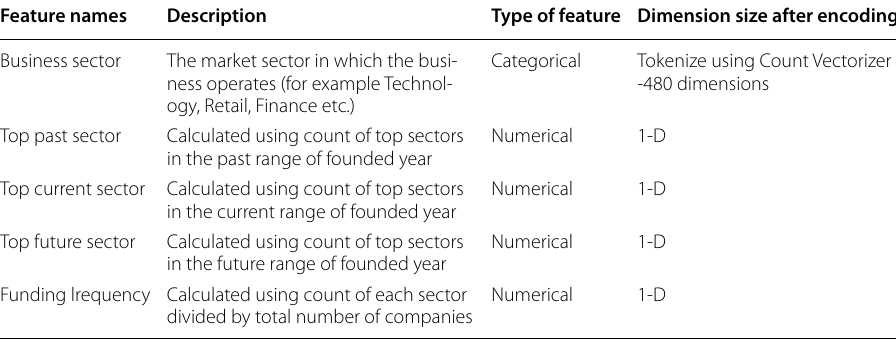
Table 3 A description of Market Features used in the prediction model